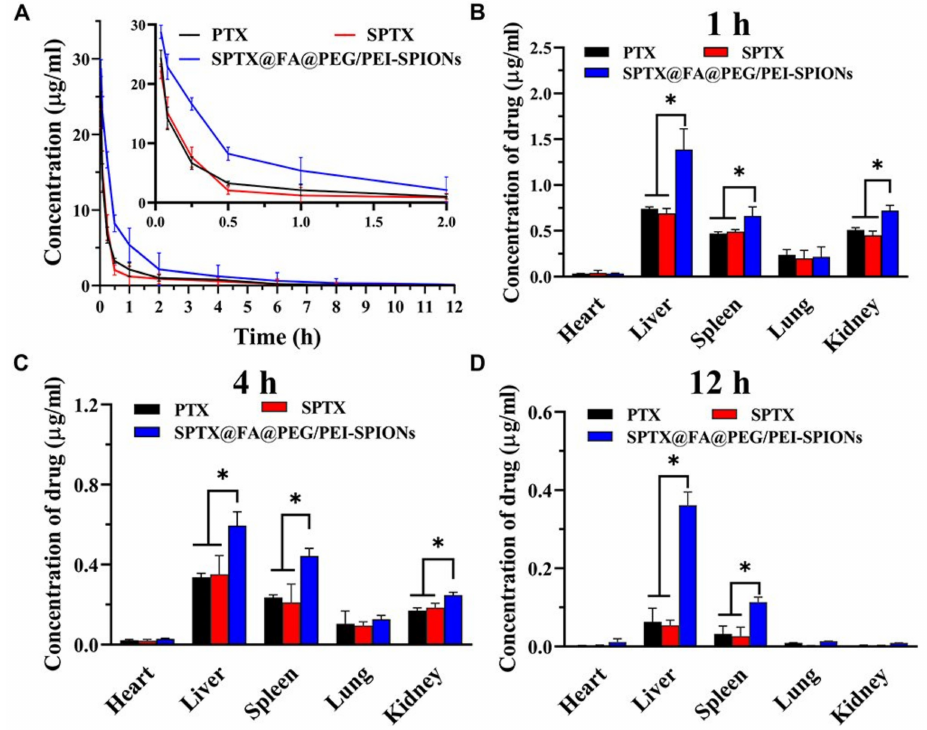
Figure 12. Plasma concentration–time curves of free PTX, SPTX, and SPTX@FA@PEG/PEI-SPIONs in vivo, data are expressed as the mean ± SD ( n = 4) ( A ). Tissue distributions of free PTX, SPTX and SPTX@FA@PEG/PEI-SPIONs at 1 h ( B ), 4 h ( C ) and 12 h ( D ) post-intravenous injection ( n = 4), * p < 0.05. Reprinted from [88], license CC BY